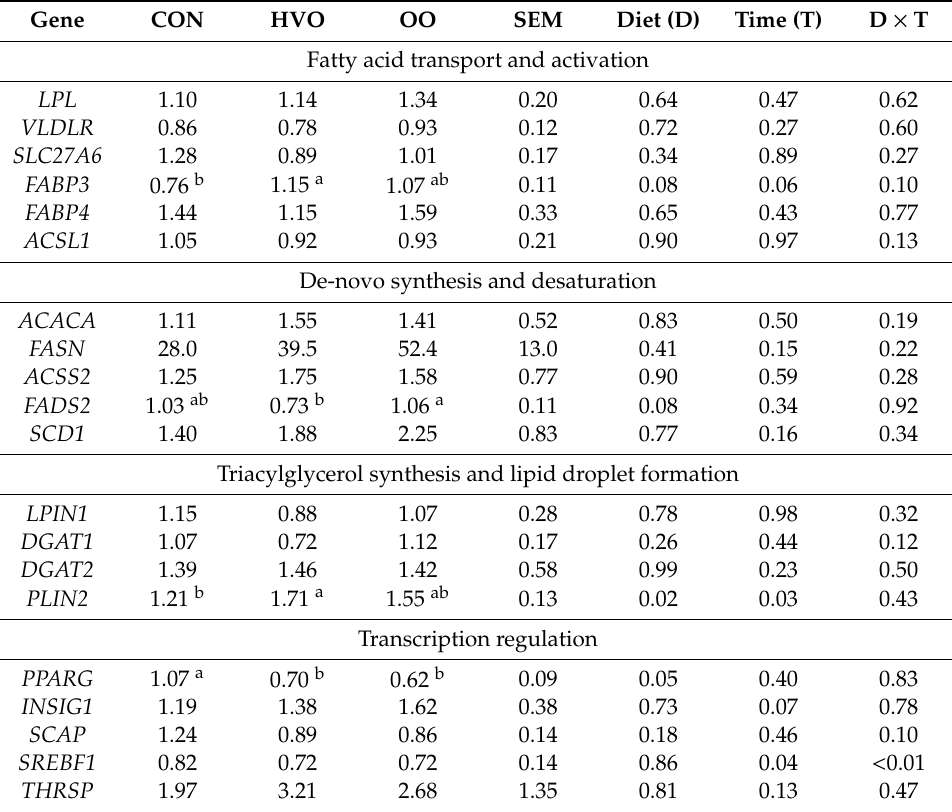
Table 2. E ff ect on the transcription of genes related to lipid metabolism in subcutaneous adipose tissue (SAT) of cows fed with no fat supplement (CON), 30 g / kg DM olive oil (OO), or 30 g / kg DM hydrogenated vegetable oil